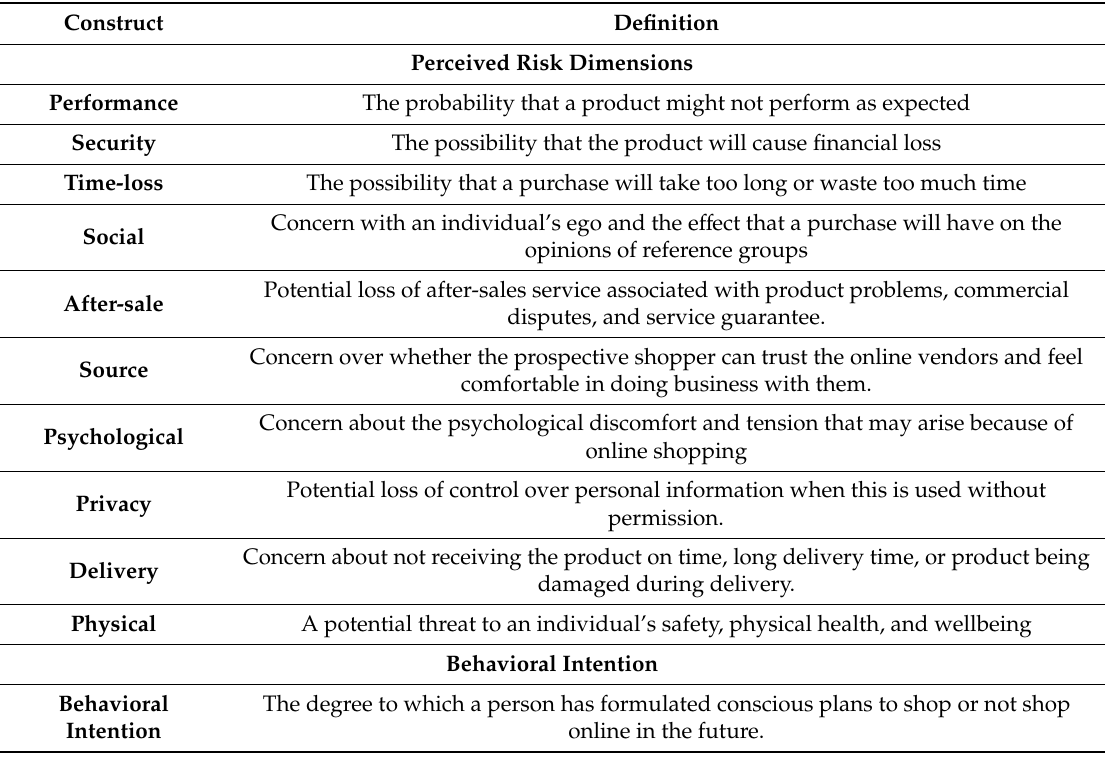
Table 1. Construct